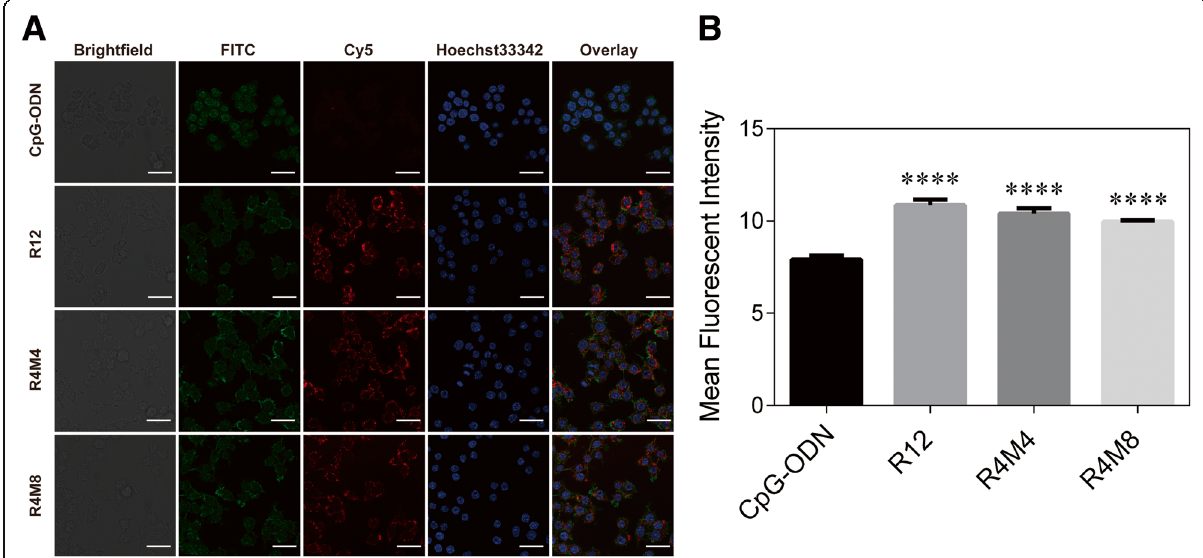
Fig. 2 The images of confocal microscope and mean fluorescent intensity in RAW 264.7 cells treated with CpG-ODN, CpG-RCA gel (R12), and CpG-MCA gels (R4M4 and R4M8) (100 nM CpG equivalents). CpG-MCA gels and CpG-RCA gel were labeled with Cy5 (red) through adding Cy5- dCTP for their cellular uptake. Cy5-labeled CpG-ODN was used as a control group. a Confocal microscopy images of CpG-RCA gel and CpG-MCA gels by RAW 264.7 cells after incubated for 2 h. b The mean fluorescent intensity of Cy5 in RAW264.7 cells. Results are expressed as the mean ± SD of three independent experiments. **** P <